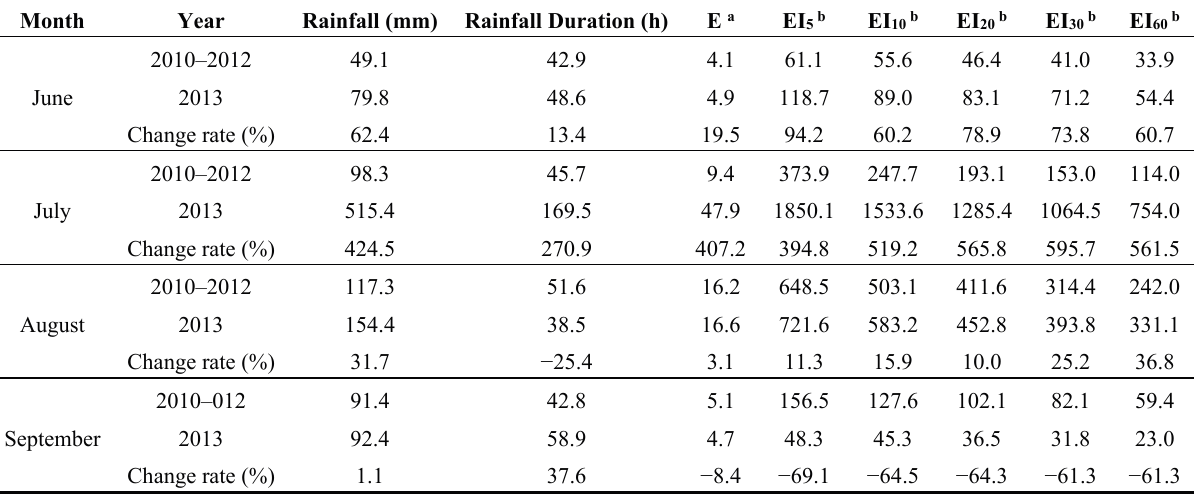
Table 2 Comparing the monthly rainfall parameters in the “extreme year” (2013) with those in the “normal year”